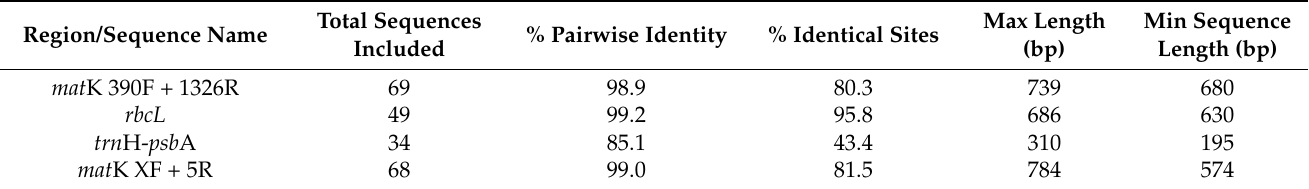
Table 2. Summary of the sequences used as barcoding molecular markers in this study and relevant information after BLAST search in